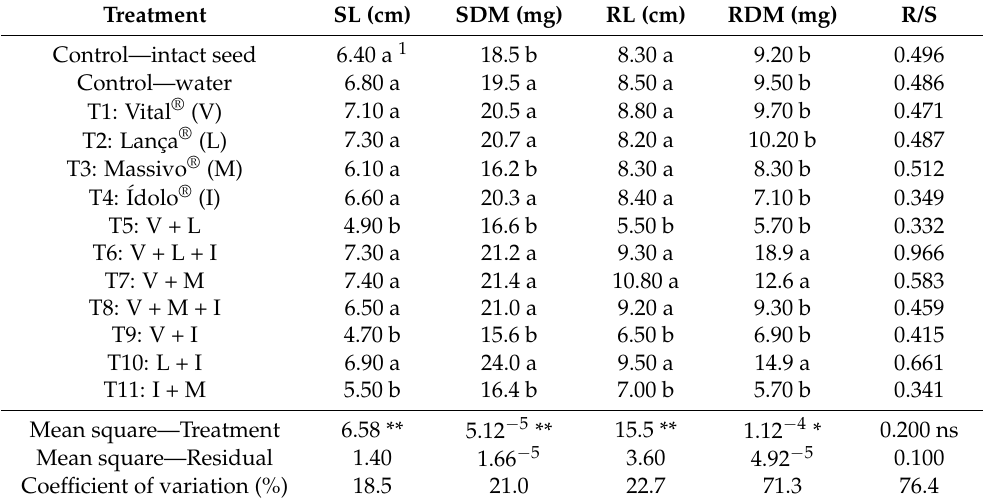
Table 2. Average shoot length (SL), shoot dry matter (SDM), root length (RL), root dry matter (RDM), and root-to-shoot ratio (R/S) of soybean NS7667 IPRO seedlings from different seed treatments. Jata í , GO, Brazil, 2022.